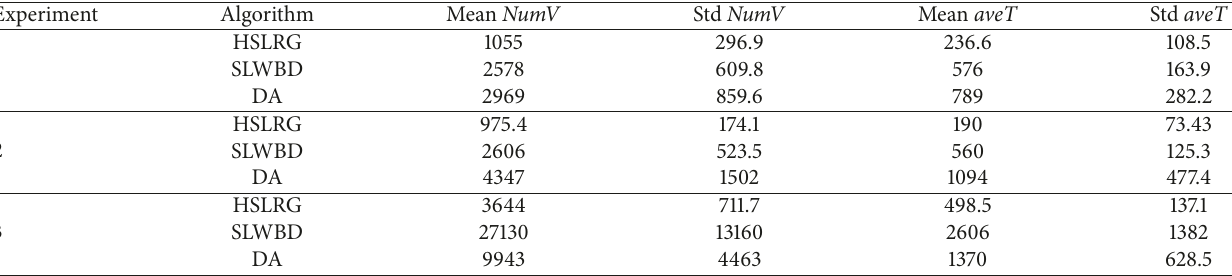
Table 4: Mean and Std of Experiment